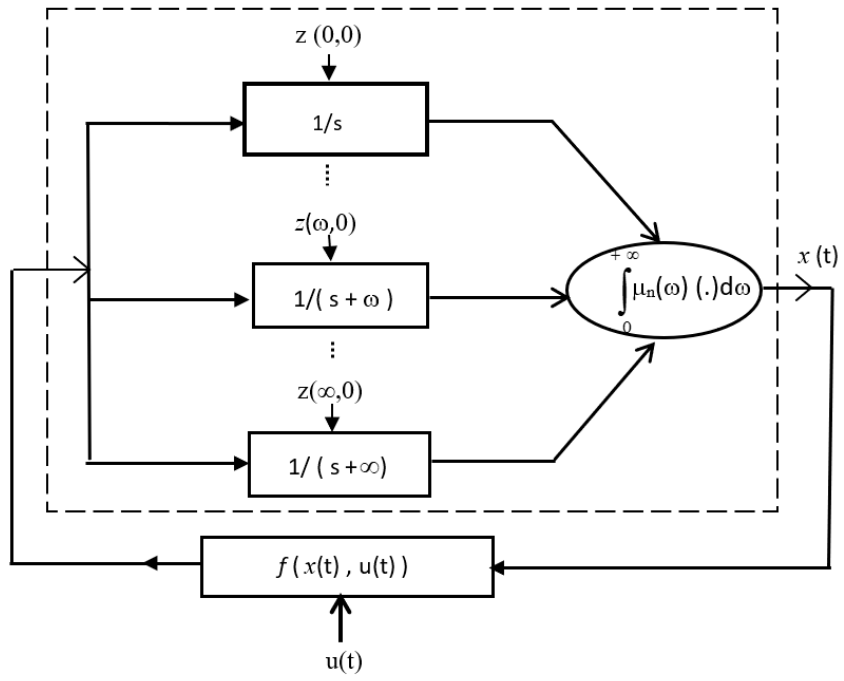
Figure 4. Closed-loop model of the FDE/FDS based on the fractional integrator distributed-frequency model.